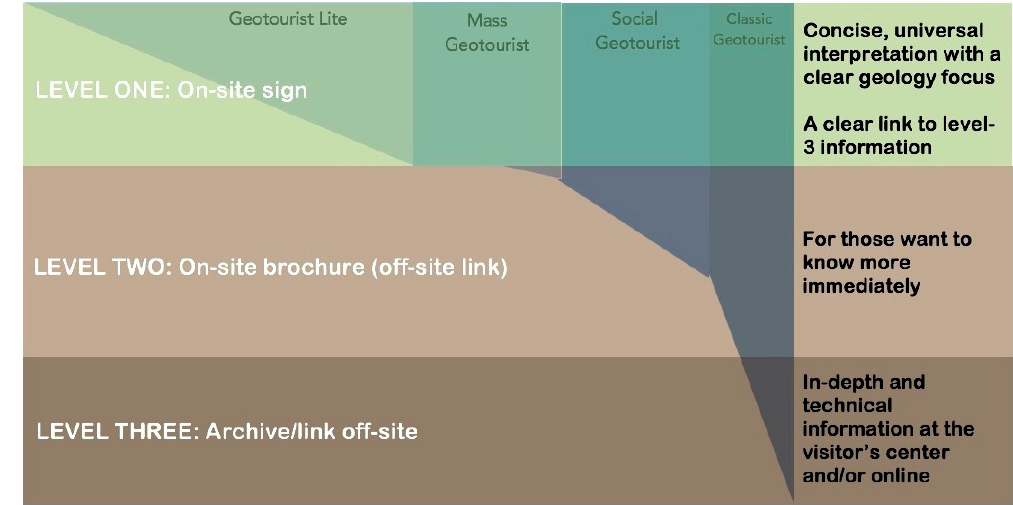
Figure 4. Interpretive strata overlay the typology to indicate what tools different types of geotourists would theoretically like to find related to geosites. The top or surface layer (1) is interpretation while the deepest or bottom layer (3) is strictly information. the deepest or bottom layer (3) is strictly